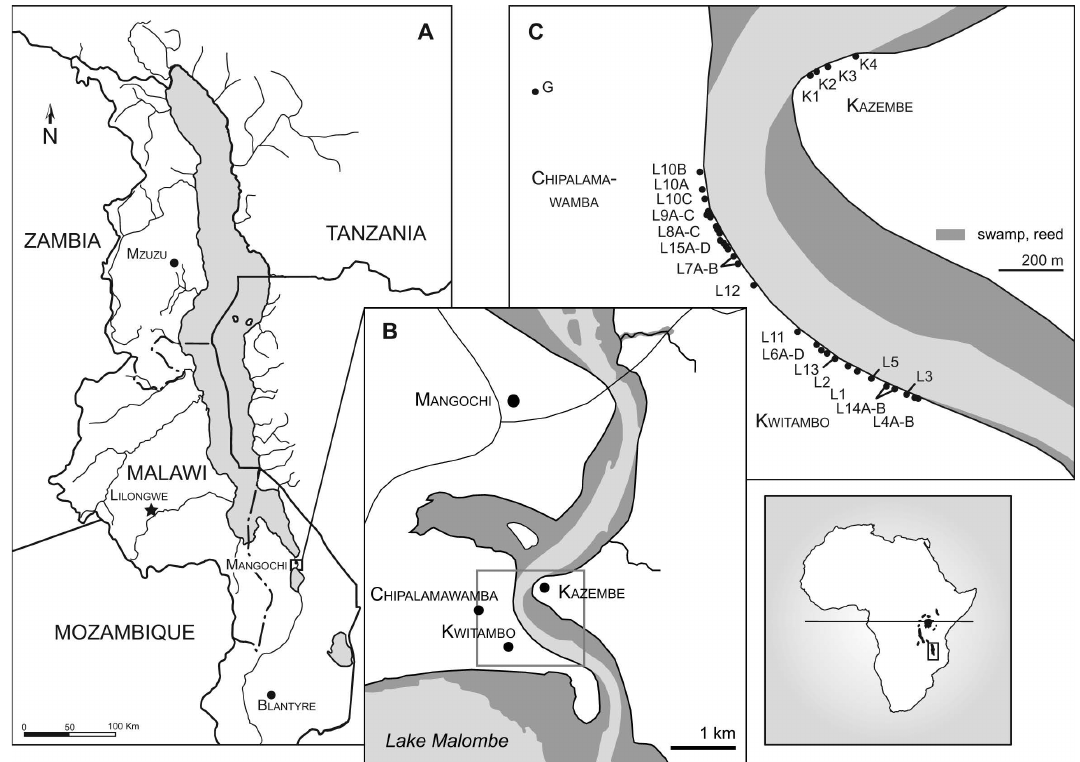
Fig. 1. (A) Lake Malawi with inflowing rivers illustrating the small catchment of the Malawi Basin. (B) The Mangochi region between Lake Malawi and Lake Malombe; the study area in the grey rectangle is enlarged in (C) . (C) Outcrops nearby Chipalamawamba, Kwitambo and Kazembe with their locality codes. G indicates Chipalamawamba sediments dug up by locals at the